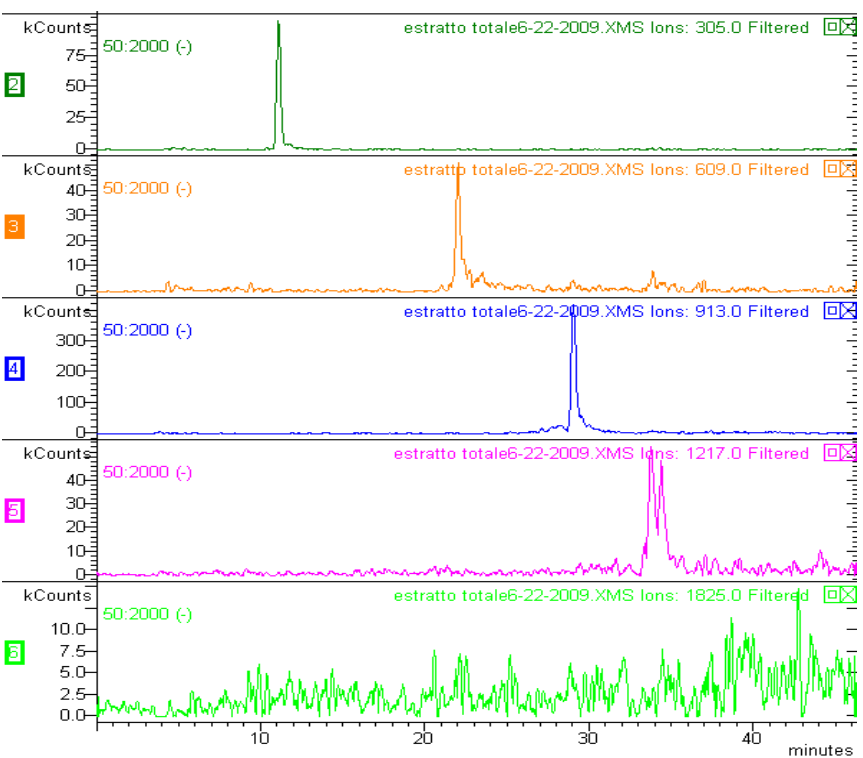
Figure 2. LC-MS chromatogram of the methanol A. spectabilis bark